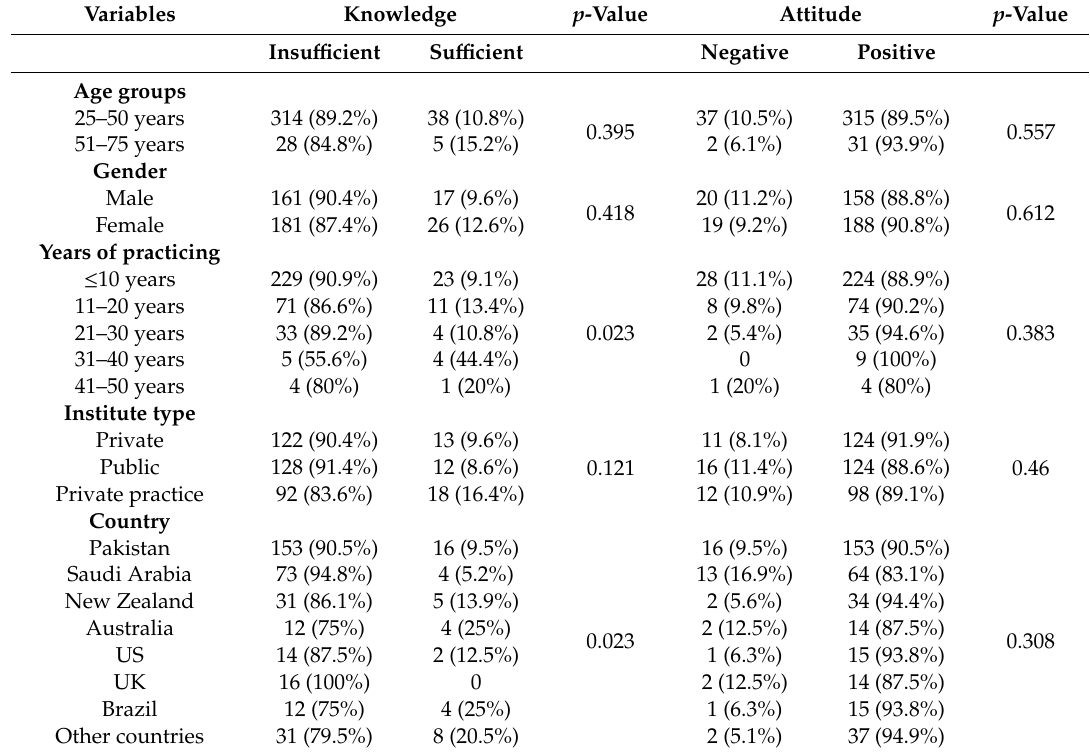
Table 4. Comparison of knowledge and attitude with the baseline characteristics of dentists.